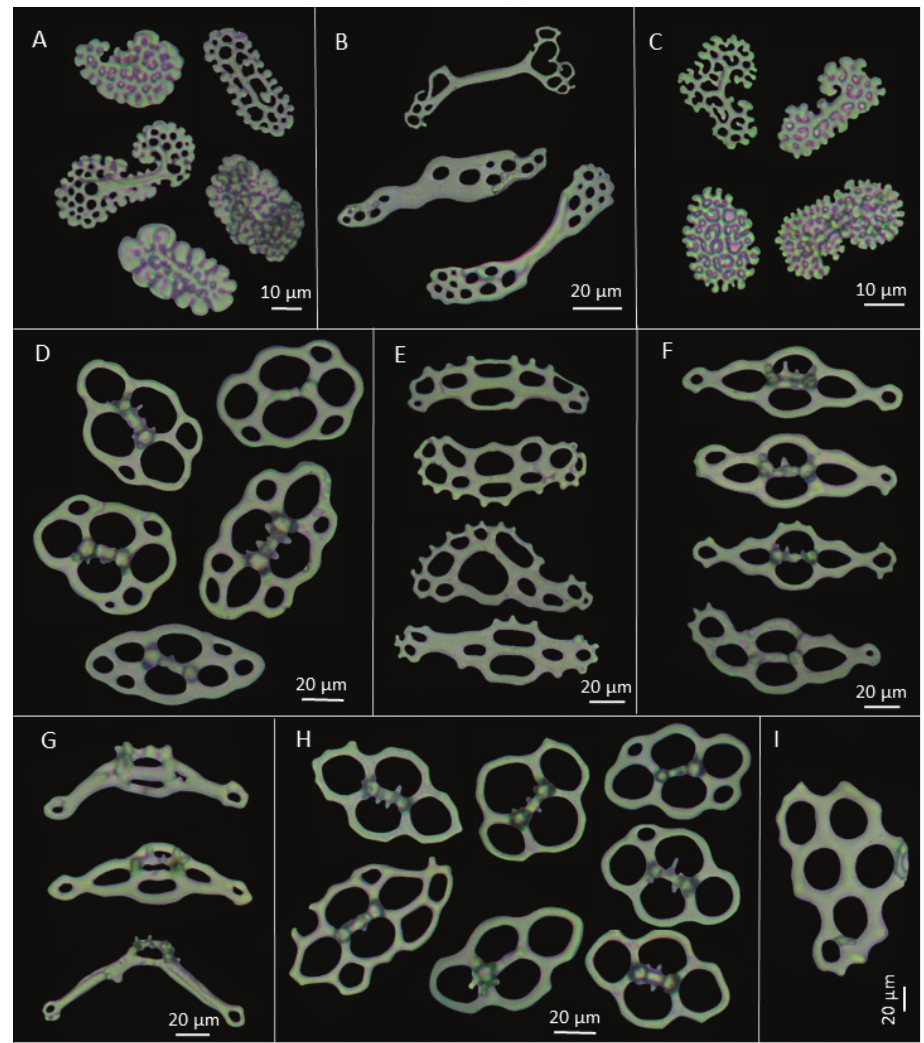
Figure 2. Pentamera paraibanensis sp. n. A Rosettes from tentacles B Rods from tentacles C Rosettes from introvert D Tables from dorsal body wall E Support plates from dorsal tube feet F Base of support tables from dorsal tube feet G Support tables from dorsal tube feet H Tables from ventral body wall, the more elongated table was found near the anus I Large plate of tube